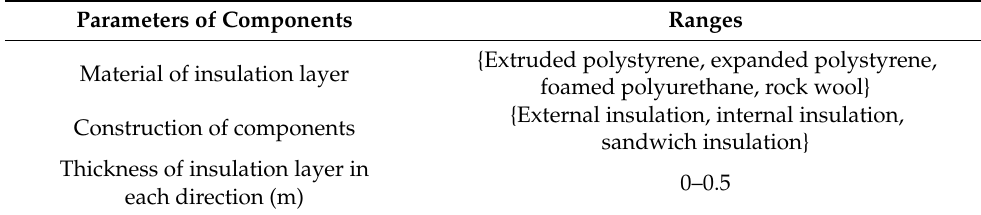
Table 3. Ranges of the component selection method’s